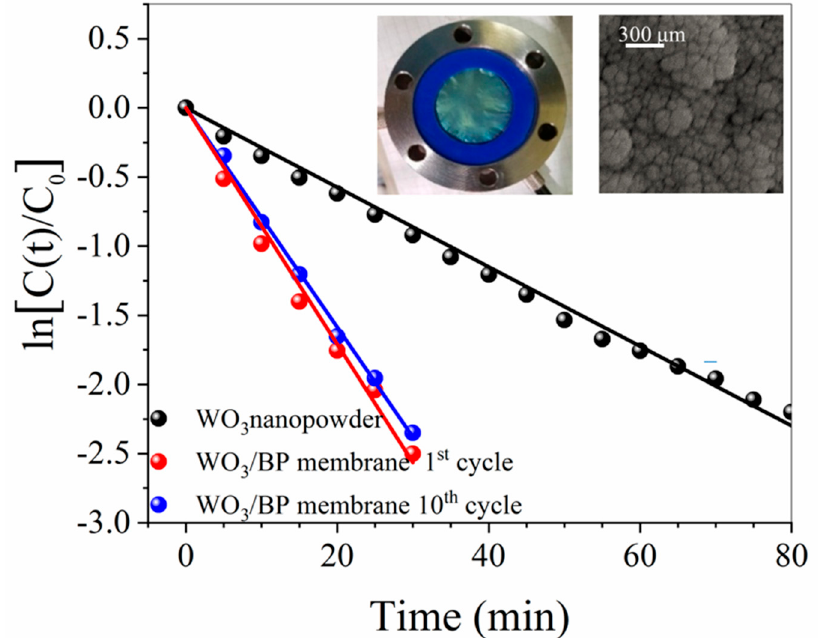
Figure 10. Photodegradation of Methylene Blue by a WO 3 / BP membrane (red dots) and by monoclinic WO 3 nanopowder (black dots) in the same amount of WO 3 present on WO 3 / BP membrane.